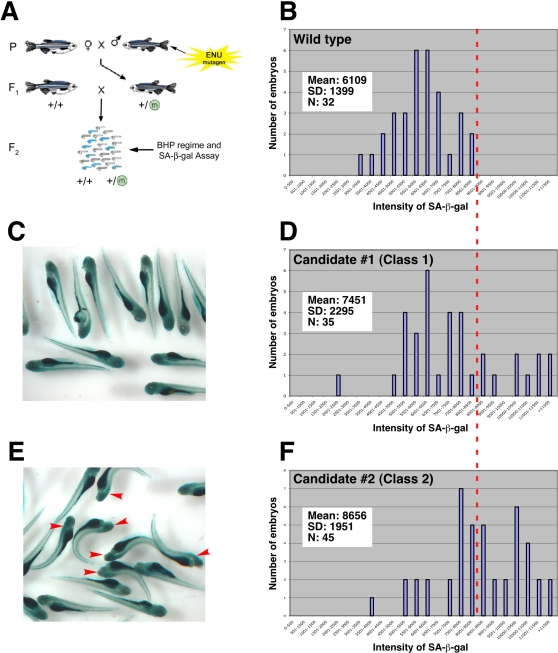
CASH screening methodology and mutant candidate identification.(A) Schematic representation of mutagenized wild-type male zebrafish bred with wild-type females. Males from the resultant F1 generation are raised and outcrossed with wild-type females. The resultant embryo clutches will be 50% wild type and 50% heterozygous with respect to a mutation generated in the parental (P) gametes. These F2 embryos are treated with moderate levels of BHP and stained for SA-β-gal activity (C). Quantitation of the staining levels is then performed. Embryo counts are grouped into 500-pixel intensity cohorts and plotted. (B) Wild-type embryos show a tight Gaussian distribution of staining intensity. Significantly right-shifted distributions (dotted red line in D) identify Class 1 candidates in terms of their oxidative stress sensitivity (D). Class 2 mutant candidates are identified if direct phenotypic abnormalities (red arrows) exist in approximately 50% of the embryos of clutches only in the presence of exogenous oxidative stress (an example is shown in E and F), with significantly right-shifted distributions (dotted red line in F).